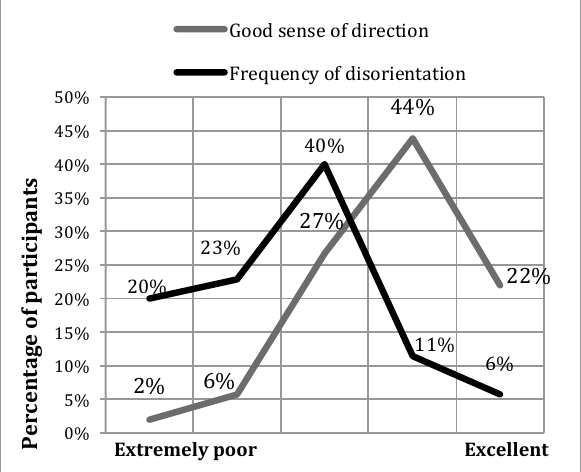
Figure 6. Graph depicting the participants’ sense of direction and their frequency of disorientation.